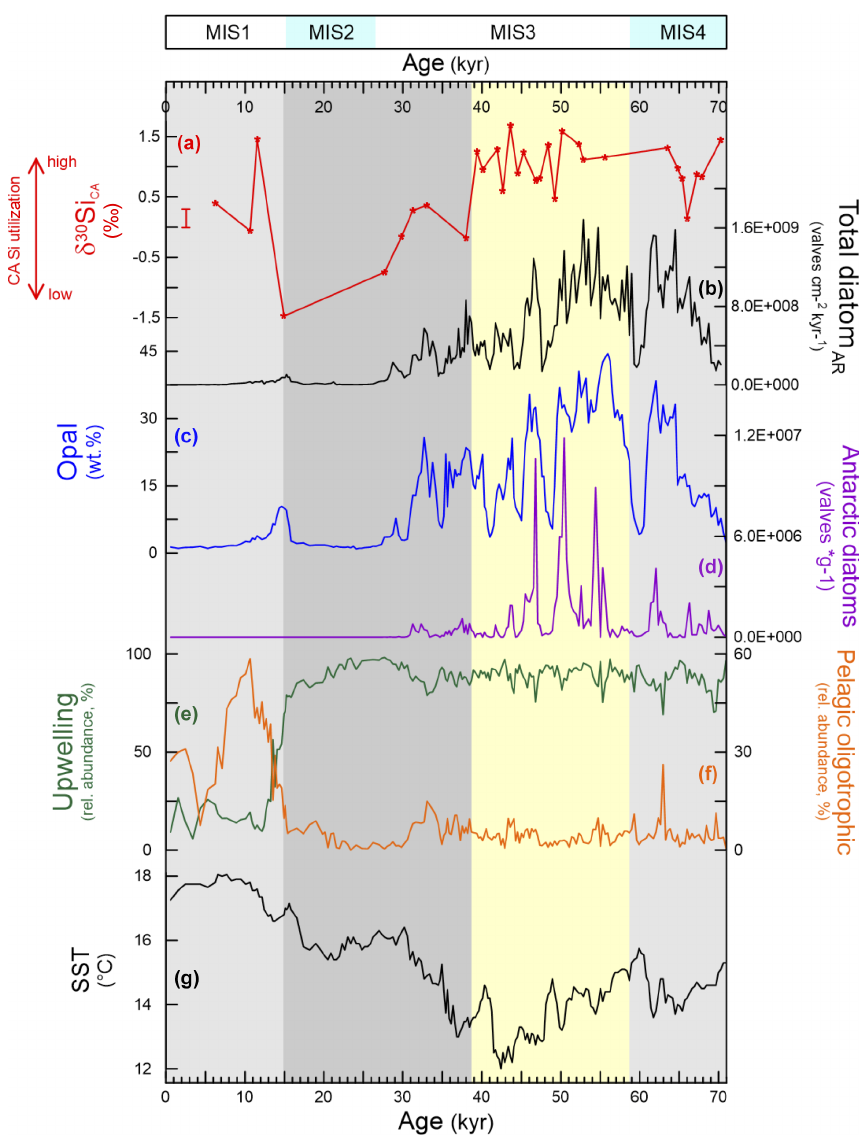
Figure 2. Comparison between diatom silicon isotope records and other archives from GeoB3606-1. (a) δ 30 Si CA records from large diatoms C. radiatus and A. curvatulus (the error bar shows long-term reproducibility based on repeat measurements of reference standards, ± 2 SD); (b) total diatom accumulation rate; (c) opal weight percent; (d) abundance of the Antarctic diatom F. kerguelensis ; (e) relative abundance of diatom species characterizing coastal upwelling; (f) relative abundance of diatom species characterizing open-ocean or pelagic conditions; (g) alkenone-based sea surface temperatures (SSTs; published data from MacKay et al., 2016; Romero, 2010; Romero et al., 2003, 2015). Vertical shaded bars highlight the time periods discussed in Sect.